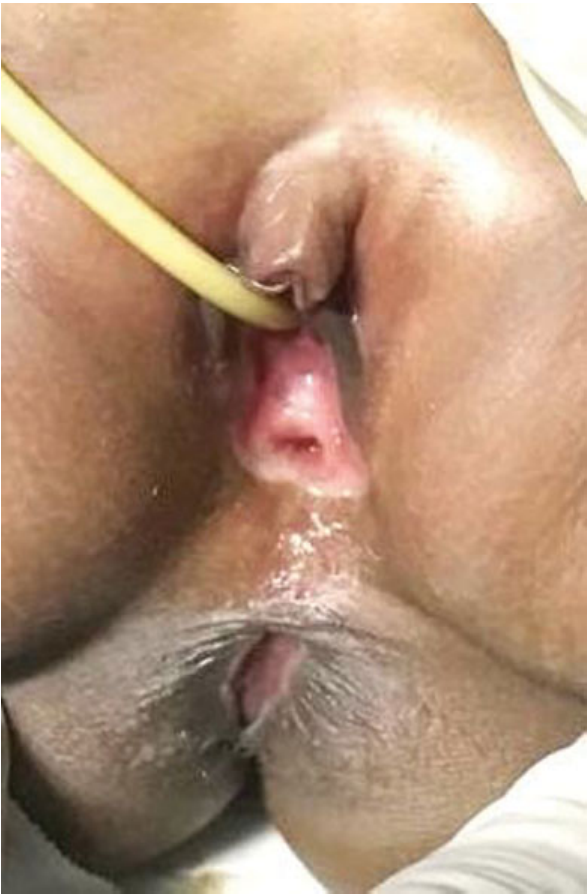
Fig. 8 Neoanus and neovaginal introitus at 2.6 years of age.